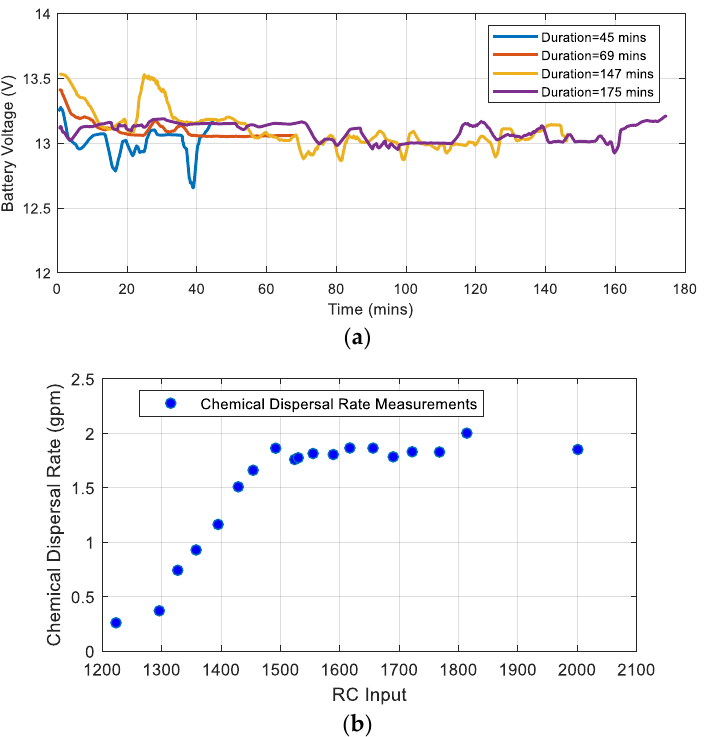
Figure 17. ( a ) Battery voltage measurements for multiple test runs and ( b ) characterization of chemical dispersal rates as a function of RC input. Voltage fluctuations were a function of power supplied to the propulsion system.